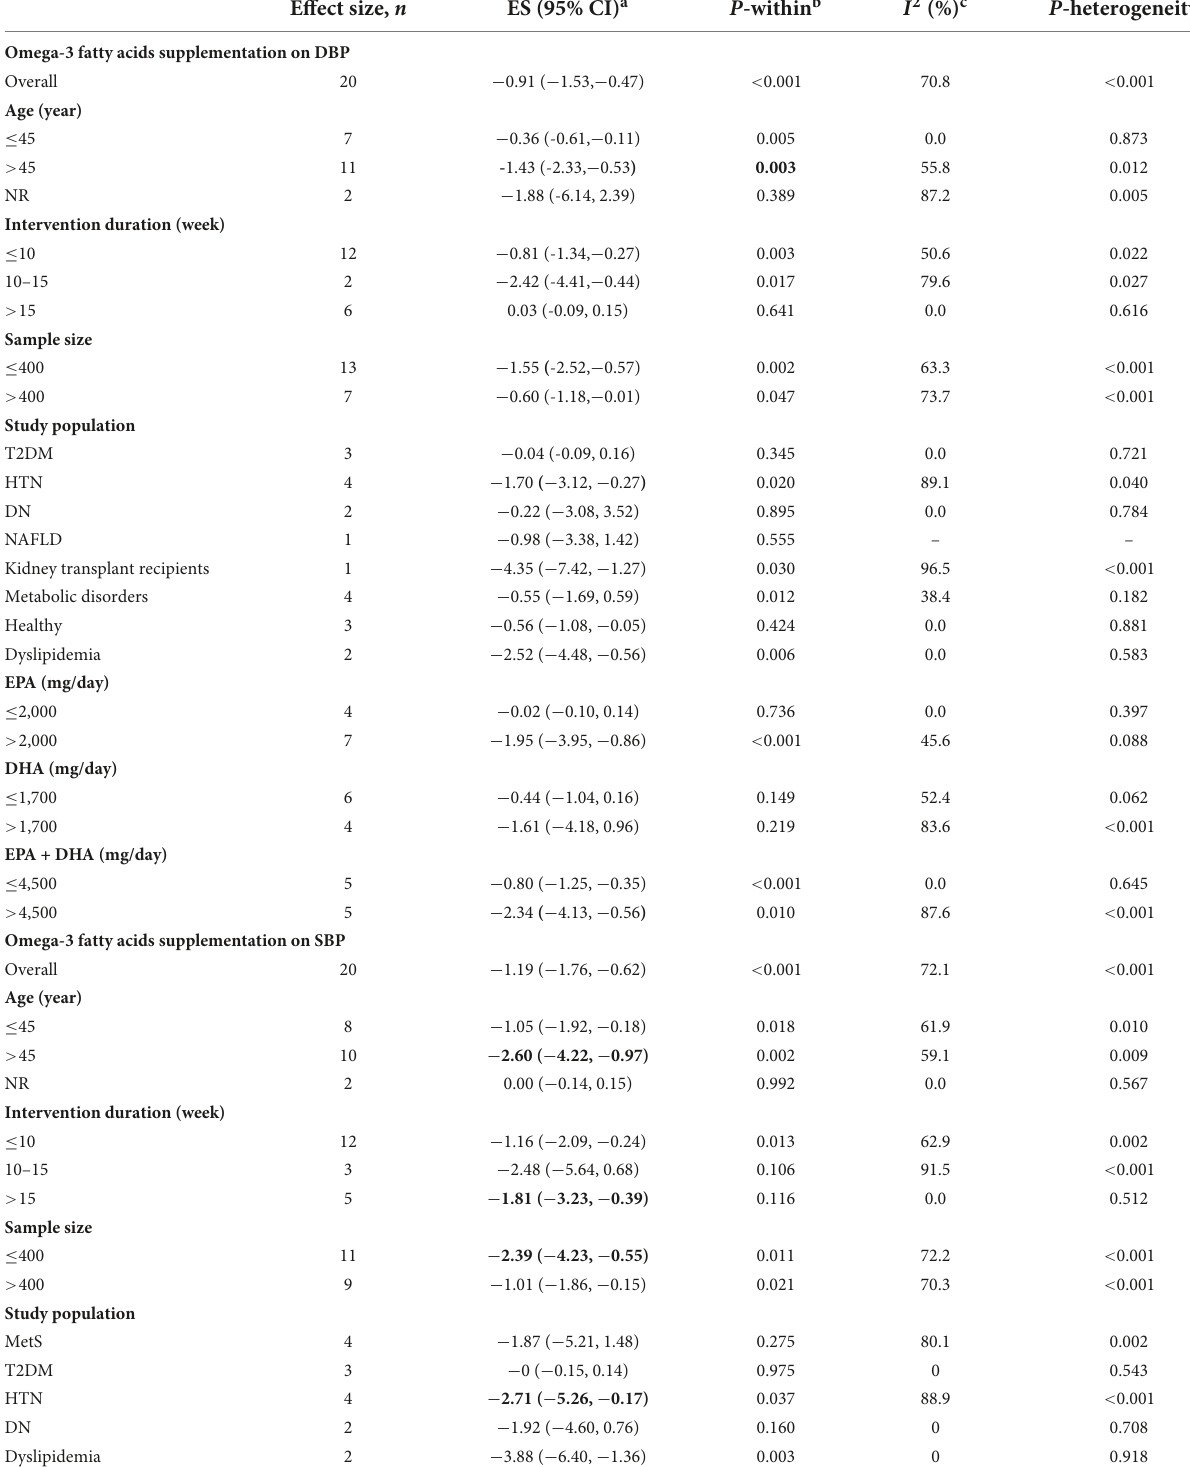
TABLE 3 Subgroup analyses for the effects of omega-3 fatty acids supplementation on blood pressure. Effect size, n ES (95% CI) a P -within b I 2 (%) c P -heterogeneity